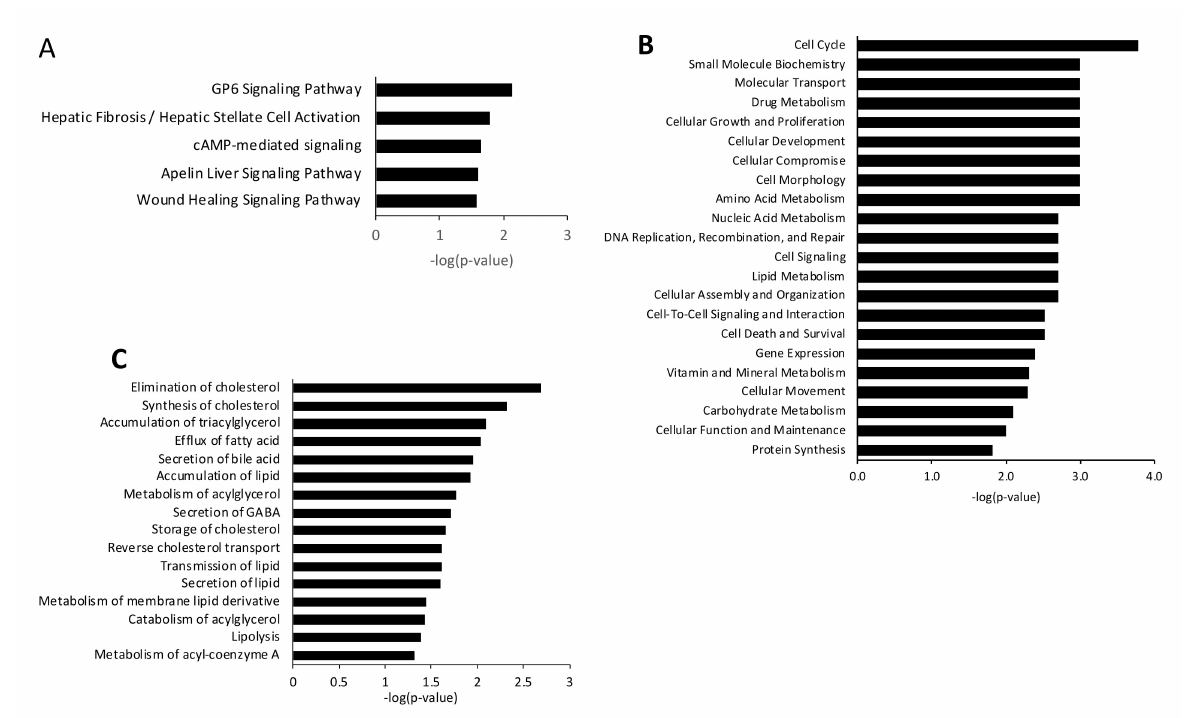
Figure 6. Significant canonical pathways ( A ), cellular and molecular functions ( B ), and lipid metabolism pathways ( C ), enriched with the 31 overlapping genes between StCs and